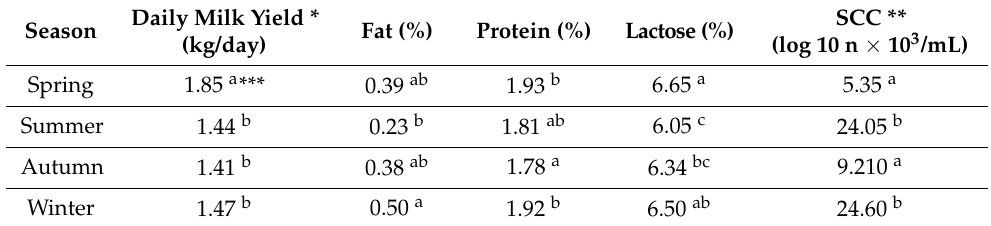
Table 3. Effect of the production season on the main qualitative variables [21].